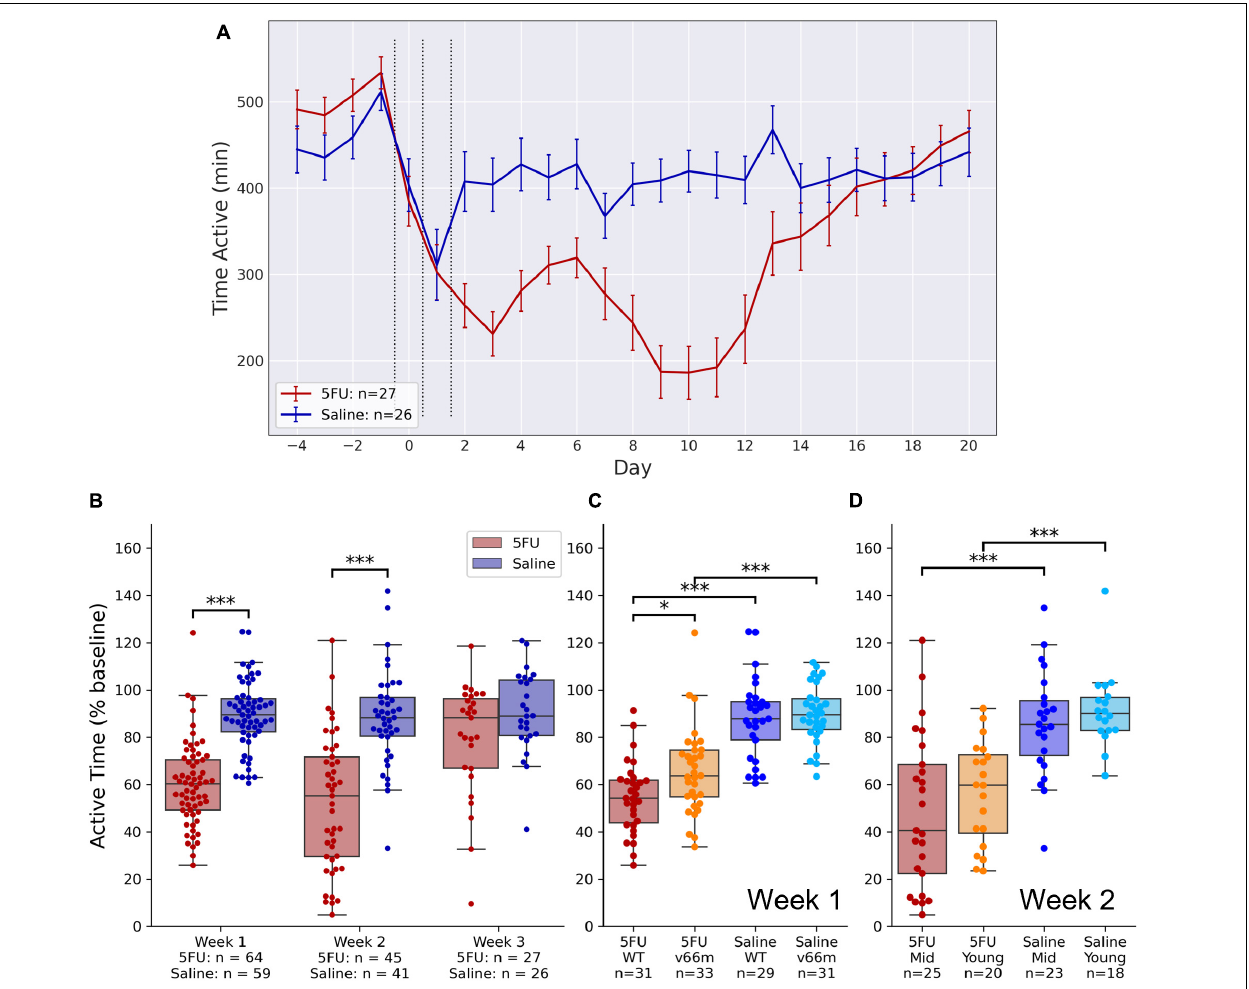
FIGURE 2 | VWRA after 5FU injection. Mice were injected with 50 mg/kg 5FU or saline once per day for 3 days, and VWRA was tracked for 3 weeks. (A) VWRA (time active) on the running wheels for each baseline day. The 5FU group shows a clear fatigue-like phenotype with VWRA nadirs during the first week and the second week. Group differences in VWRA appear to end during the third week. (B) The fatigue-like phenotype is expressed as the change in VWRA relative to baseline. VWRA differences between the 5FU and saline groups are statistically significant during the first week ( p < 10 – 16 ) and the second week ( p < 10 – 8 ) but not the third week ( p = 0.062). (C) The first week after receiving 5FU injection, the fatigue-like phenotype is less pronounced in Val66Met mice than in WT controls ( p = 0.012). (D) The second week after receiving 5FU injection, the fatigue phenotype is less pronounced in young than middle-aged (“Mid”) mice. ∗ p < 0.05, ∗∗∗ p <